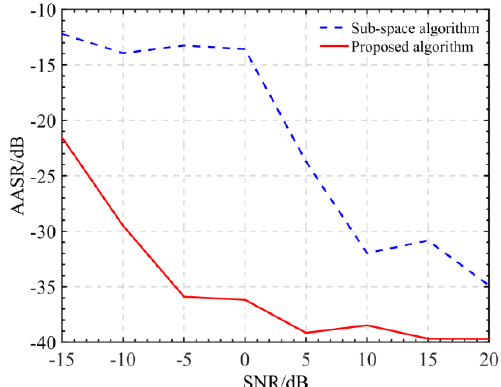
Figure 8. AASRs with different SNRs.